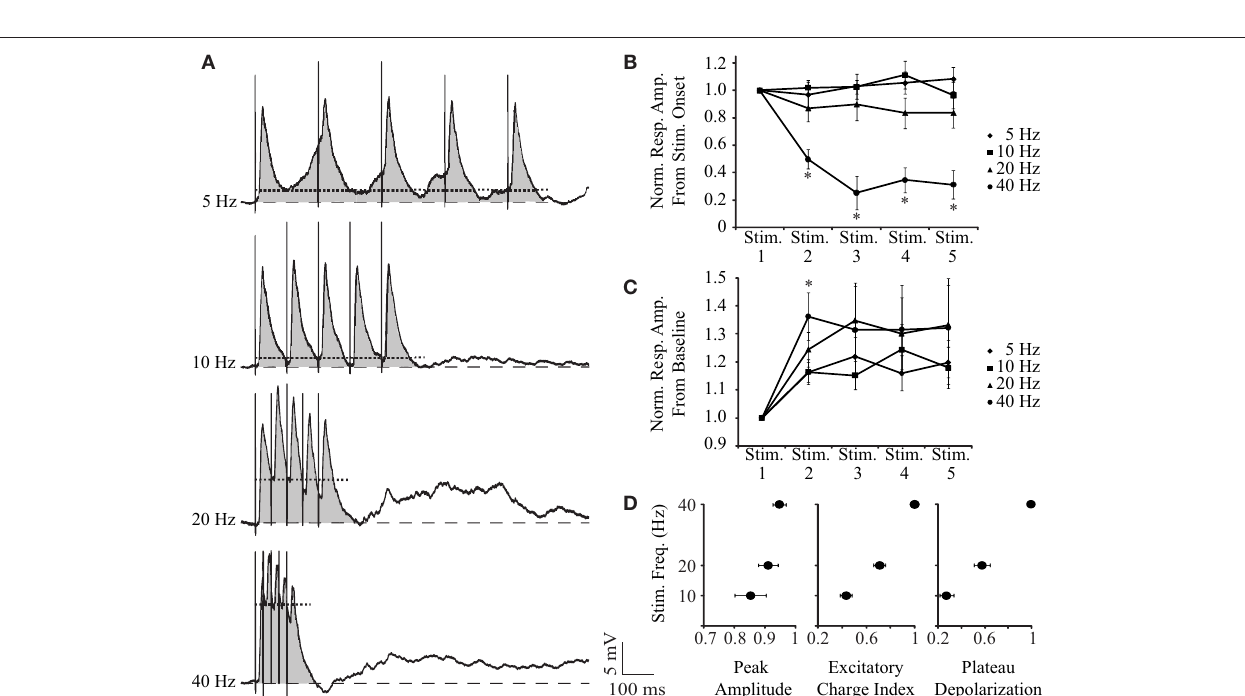
3–5 ms; gray square, 35 ms; black triangle, negative peak. (B) Population plot of reversal potentials. Single points are synaptic responses at different membrane potentials for 15 neurons. Lines represent the linear regression of the values for each of the three latencies. x -axis: voltage; y -axis: normalized amplitude of the response.